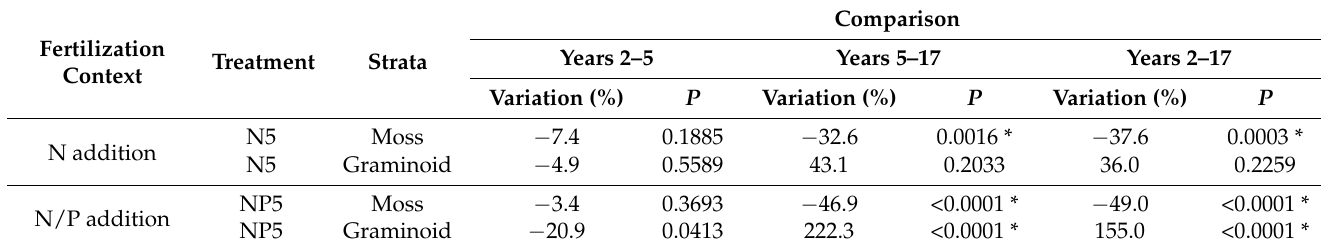
Table 4. Variation in plant cover by vegetation strata for each fertilization treatment between year 2 and year 5, year 5 and year 17, and year 2 and year 17 of the experiment in the tundra wetlands of Bylot Island, Nunavut. Significant change in vegetation strata after sequential Bonferroni correction are indicated with an asterisk * (paired t test, P < 0.0017, df =